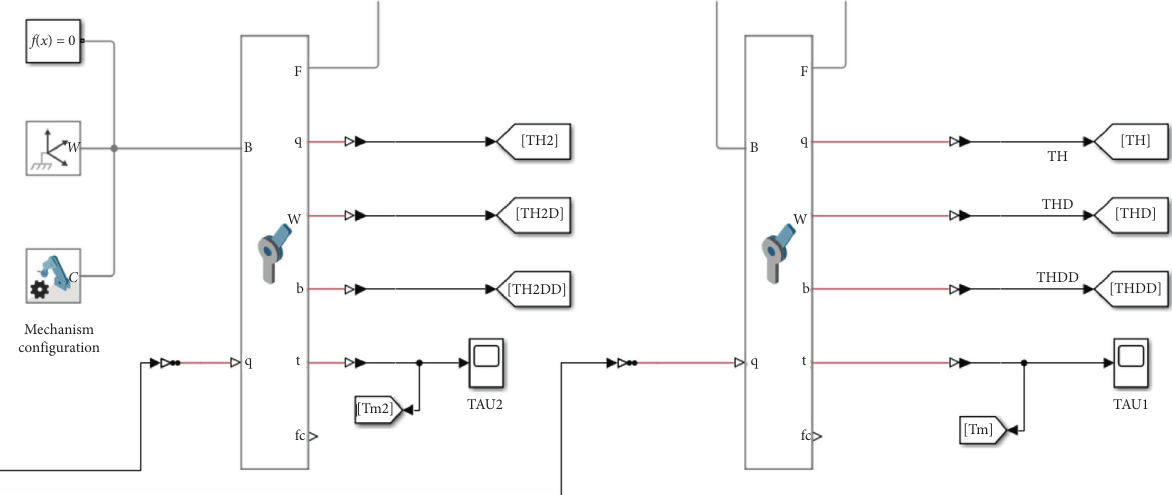
Figure 11: Revolute joint model in Simscape.